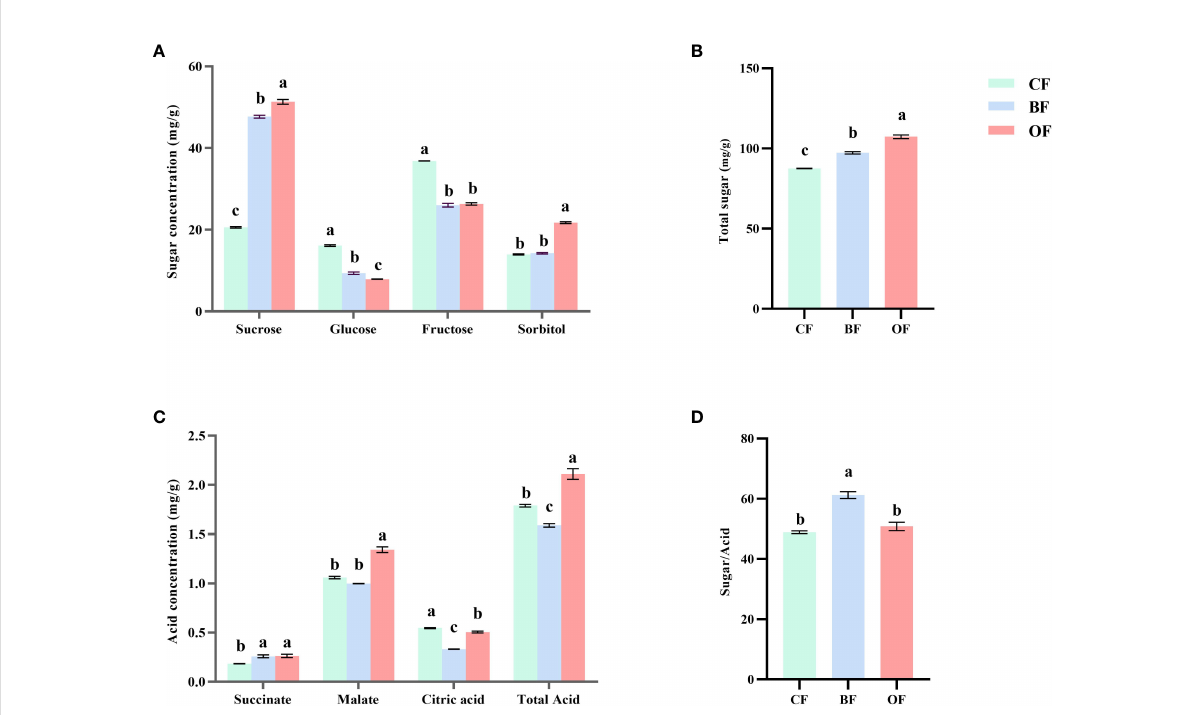
FIGURE 4 Effect of different fertilizer treatments on soluble sugar (A) , total sugar (B) , organic acids (C) and sugar/acid ratio (D) of pear fruits at the mature Stage. CF, OF and BF denote for chemical fertilizer, organic fertilizer and bio-organic fertilizer, respectively. Values followed by different letters differ signi fi cantly (Duncan ’ s test, P < 0.05, n=5 ).